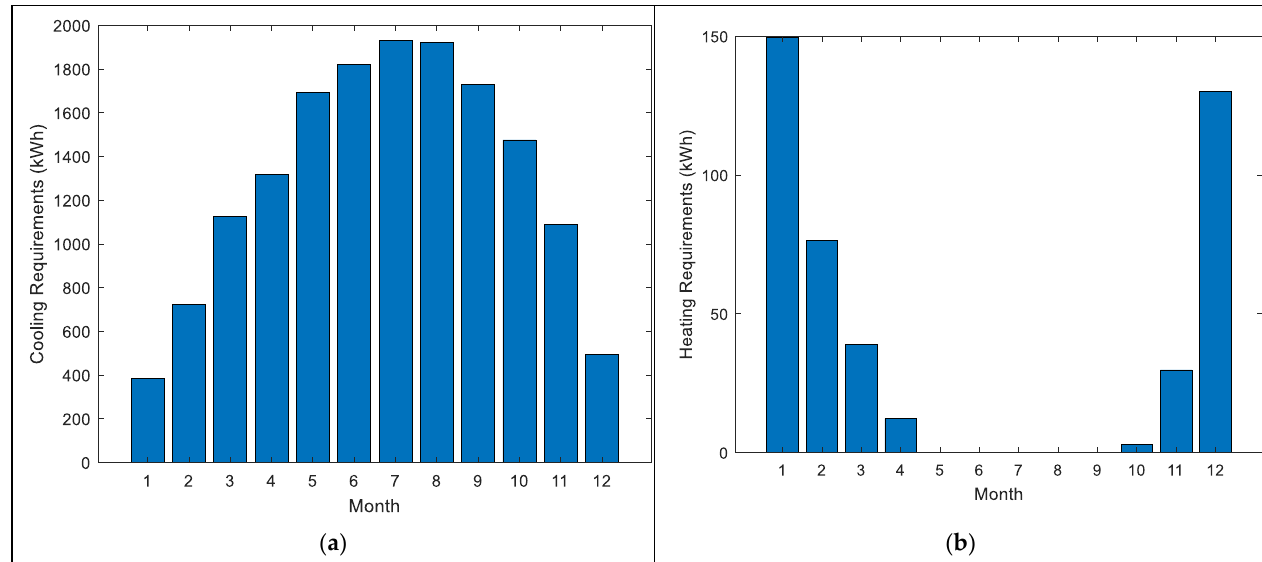
Figure 4. Hourly ( a ) cooling load for 8 July and ( b ) heating load for 26 January.